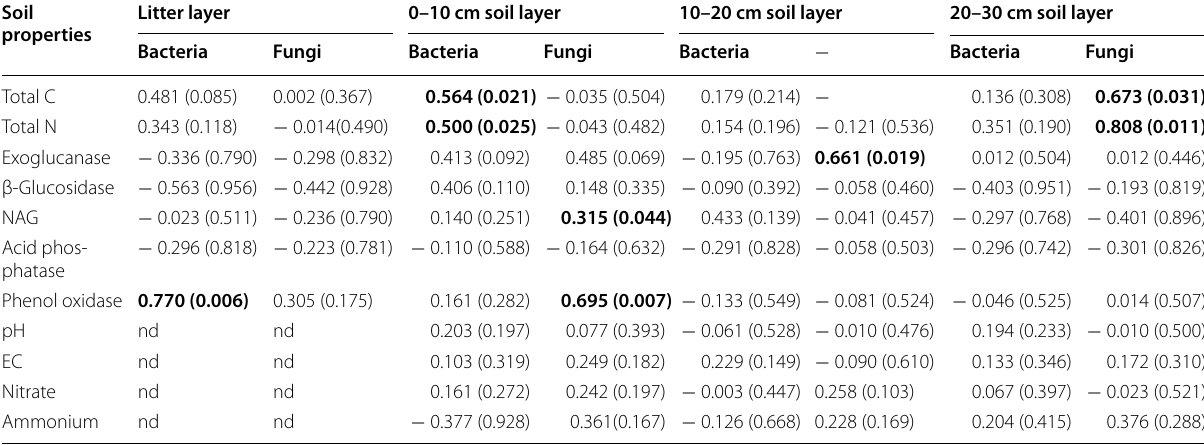
Table 3 The correlations ( r value) and significance ( P value) determined by the Mantel test between the soil properties and microbial community Soil